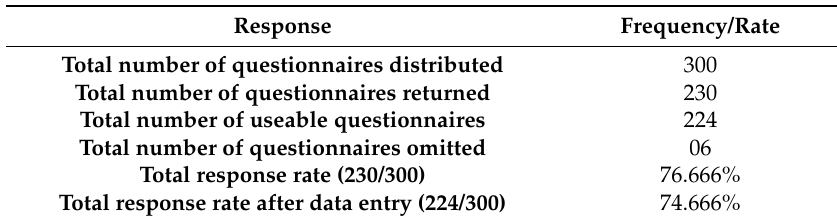
Table 2. Response